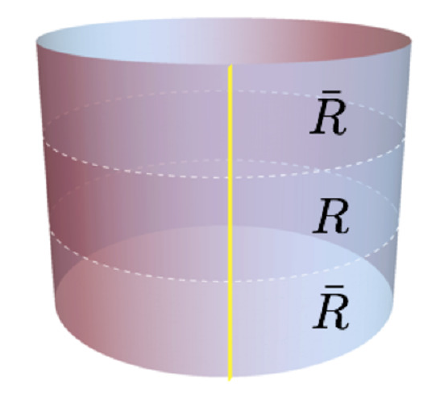
Figure 3. A cylindrical region R is embedded in a cylinder. The entanglement cut (white dashed line) separates region R and (cid:22) R . An anyon line (yellow) connects the upper and lower